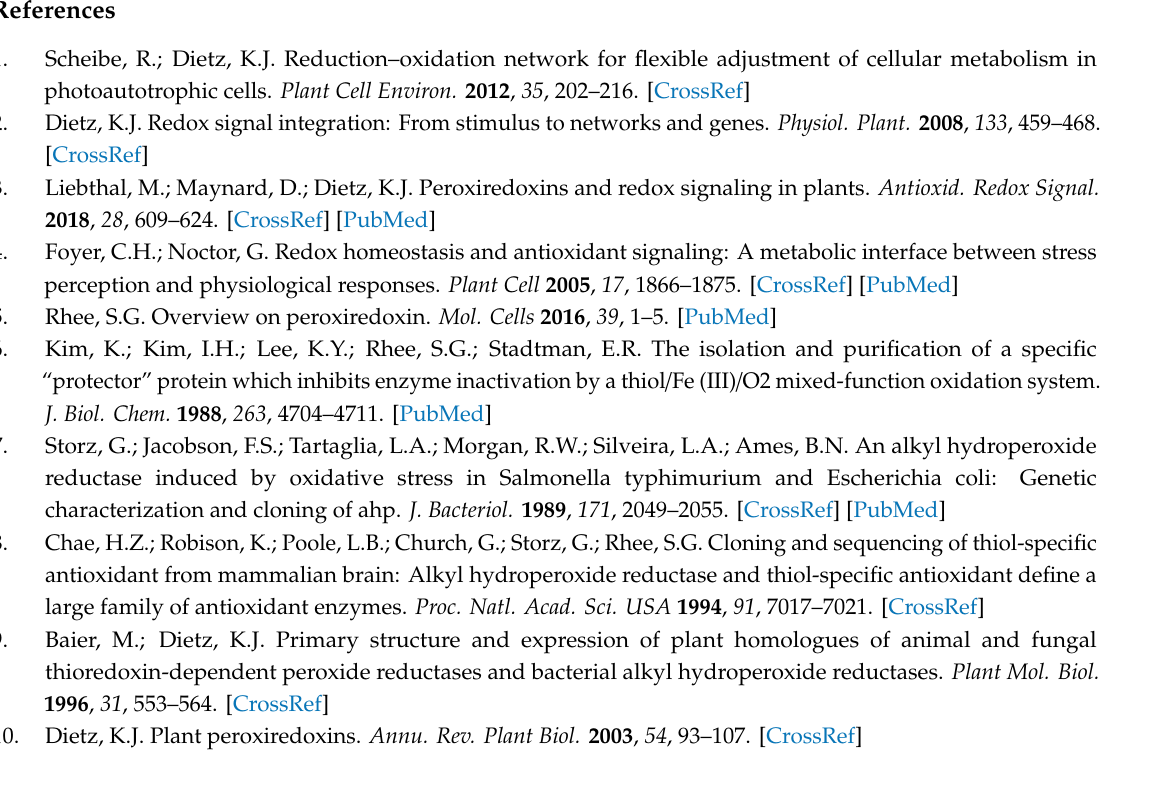
Table S1: Assignment of polypeptides identified as interactors of 2-CyspRX to gene ontology groups; Table S2: Compilation of all 178 polypeptides identified in this study and depiction of the specific conditions for their elution; Table S3: Complete list of all 178 proteins eluted in the pull down assay presented here; Figure S1: Structure of lipoxygenase 2 and analysis of Cys residues; Figure S2: Structure of chorismate synthase (CS) and analysis of Cys